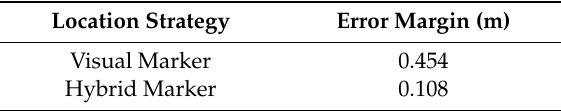
Table 3. Mean of the margins of error presented by the visual and hybrid subsystems.